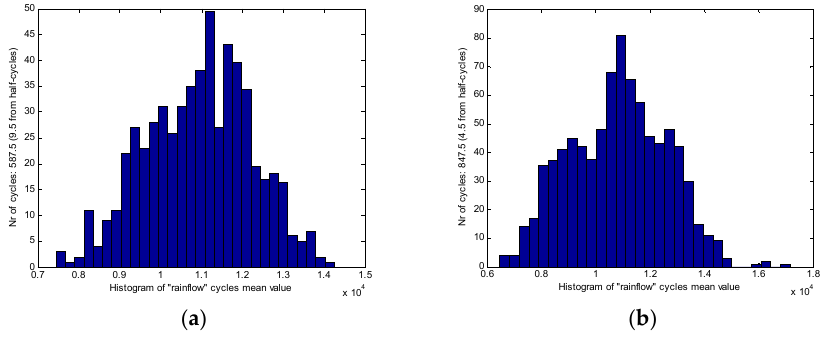
Figure 11. The mean value of the F z , ( a ) On the standard road, ( b ) On the target road.